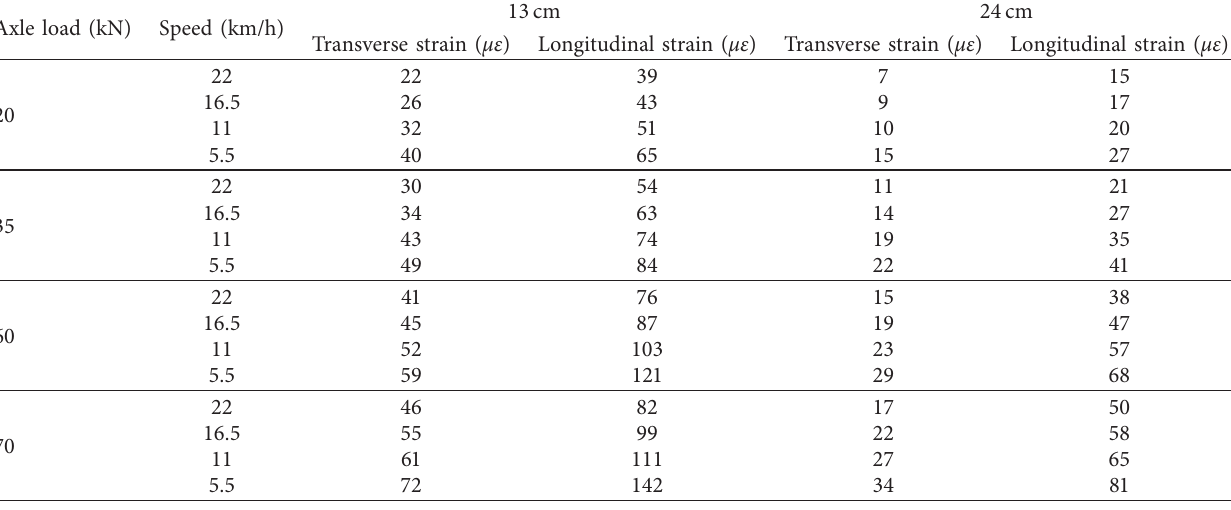
Table 7: Strains of semirigid pavement at different axle